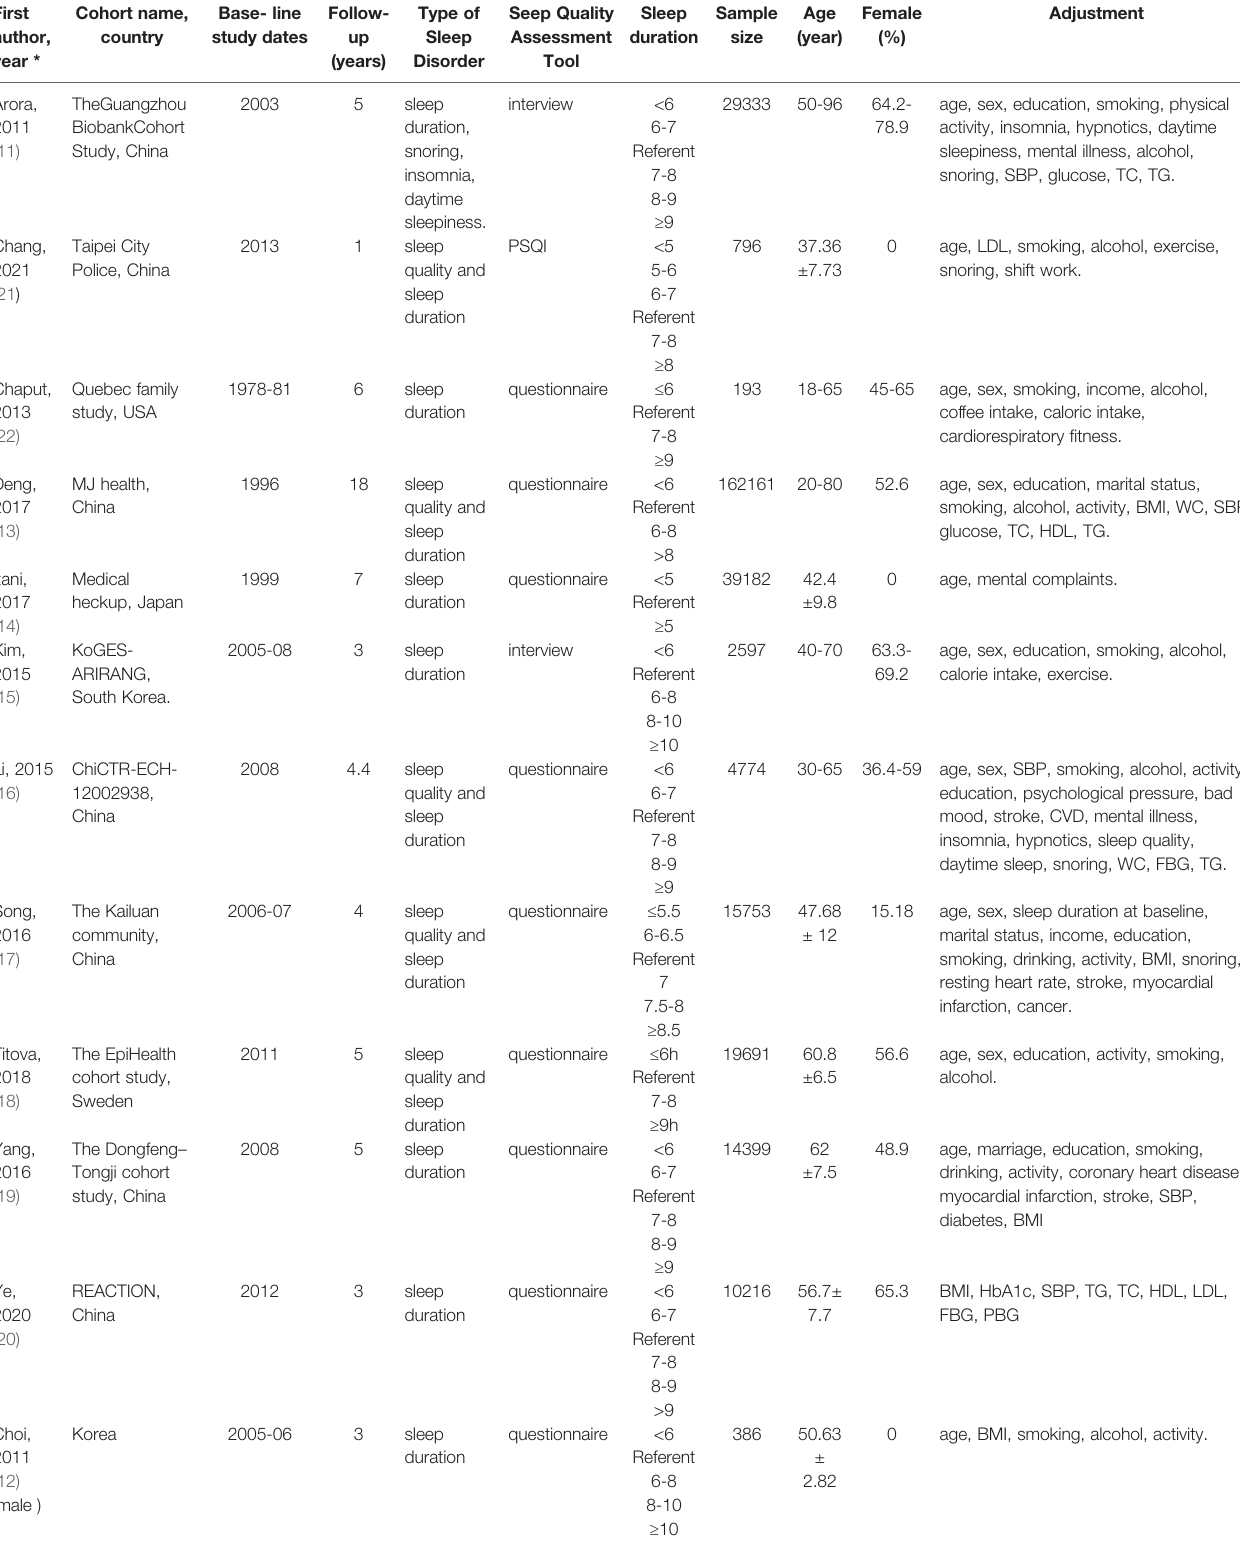
TABLE 1 | Overview of the selected studies in the meta ‐